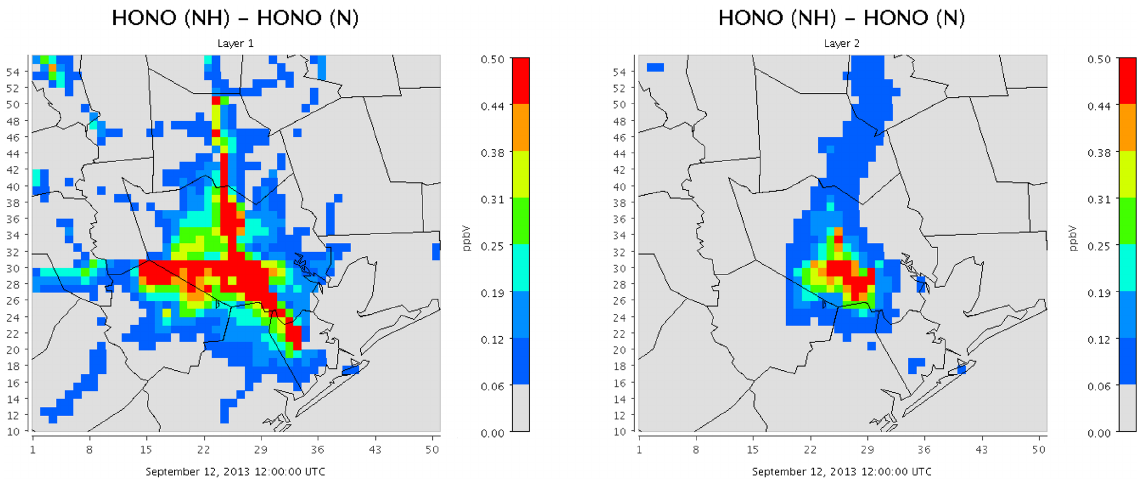
Figure 5. Differences in HONO mixing ratios between a case with 0.016 HONO / NO x emission ratio (NH) and 0.008 HONO / NO x emissions (N) for the surface (left) and the second model layer (right) at 7a.m.LT on 12 September 2013. Table 3. Statistical parameters for modeling HONO mixing ratios for the Moody Tower